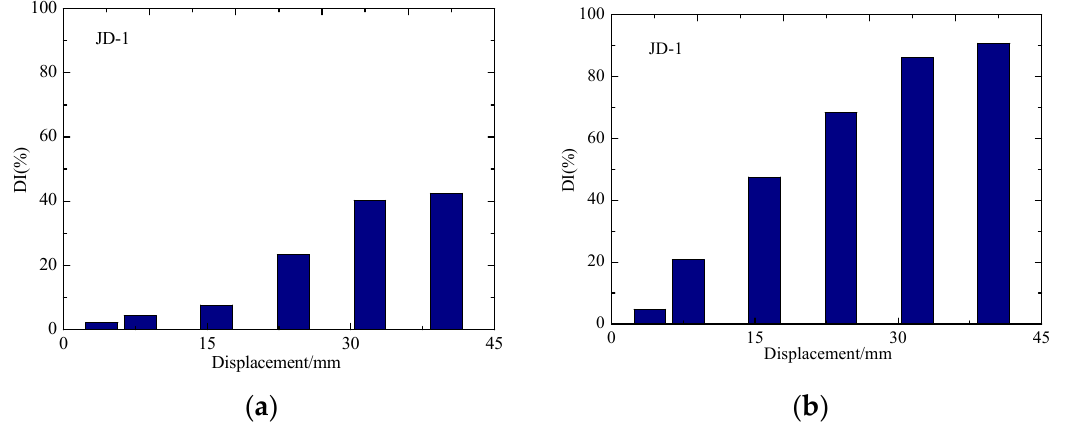
Figure 15. The damage indices of JD-1. ( a ) S1-S2; ( b ) S1-S3.